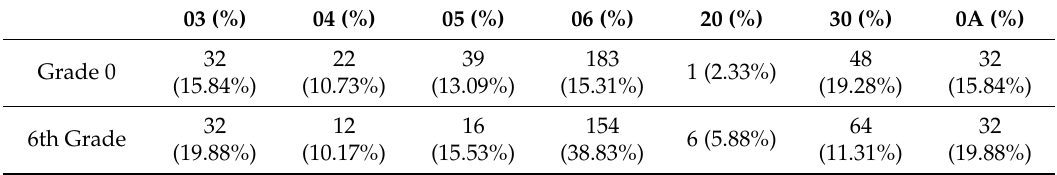
Table 5. Contribution to ICDAS score of the children who “never visited a dentist “.